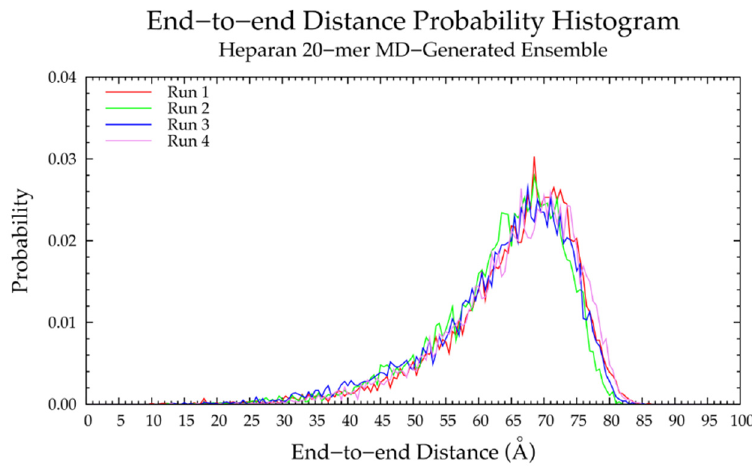
Figure 18. End-to-end distance probability distribution of constructed ensemble of nonsulfated keratan 200-mer; most probable end-to-end distance across all four sets is 305 Å; probabilities were calculated for end-to-end distances sorted into 5 Å bins; the ensemble contains four sets of 10,000 conformations.